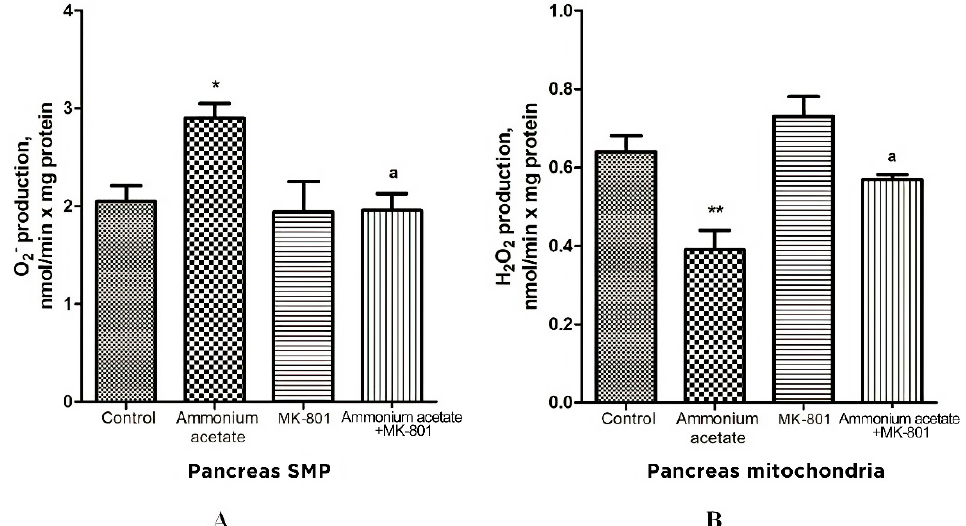
Figure 7. The effect of ammonium acetate and MK-801 injection on the rate of O 2 •− ( A ) and H 2 O 2 ( B ) formation in rat pancreas SMP and mitochondria. Experimental design was the same as in Figure 1 legend. The rates of O 2 •− and H 2 O 2 formation were determined as indicated in Materials and Methods. The results are represented as mean ± SEM. Values significantly different from the control group are designated with one (*) and two (**) asterisks: * p < 0.05, ** p < 0.01, (Student’s t -test). a significant differences, compared with ammonia group. а p < 0.05 (with the Bonferroni correction for multiple comparisons).